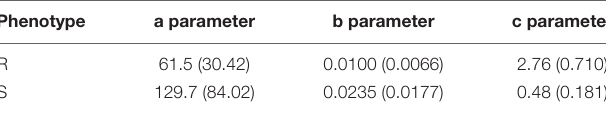
TABLE 3 | Hyperbolic model parameters for resistant (R) and susceptible (S)